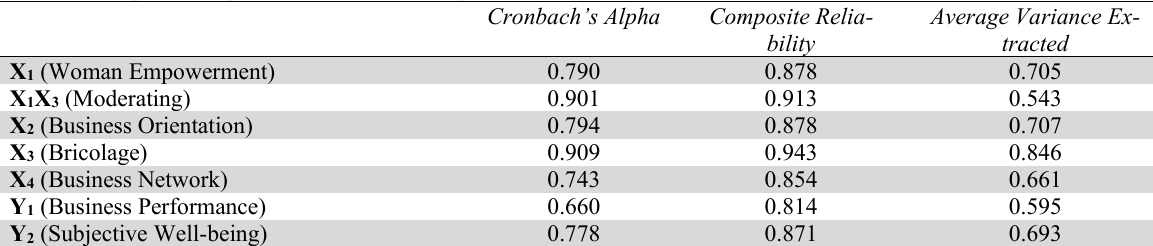
Cronbach’s Alpha , Composite Reliability, Average Variance Extracted